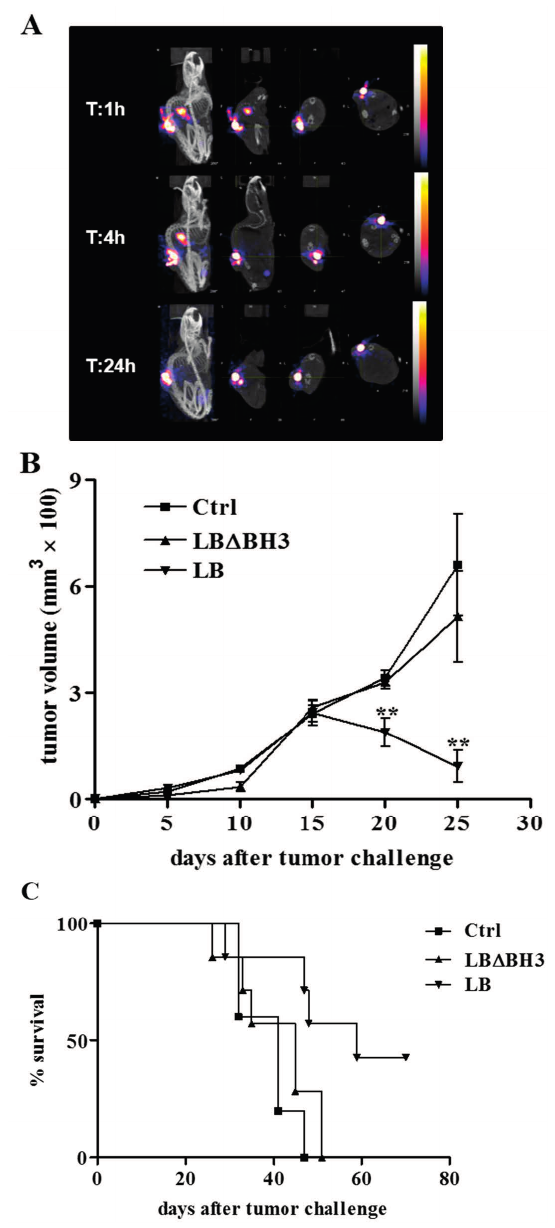
Figure 3. Intra-tumor treatment with LB in GL26-bearing mice. ( A ) SPECT/CT images at 1, 4 and 24 h after treatment with a single intra-tumor injection of 99m Tc-LB; ( B ) GL26 tumor growth over time. ** p < 0.01, LB vs. Ctrl and LB Δ BH3; ( C ) Survival curves. p < 0.05, LB vs. Ctrl and LB Δ